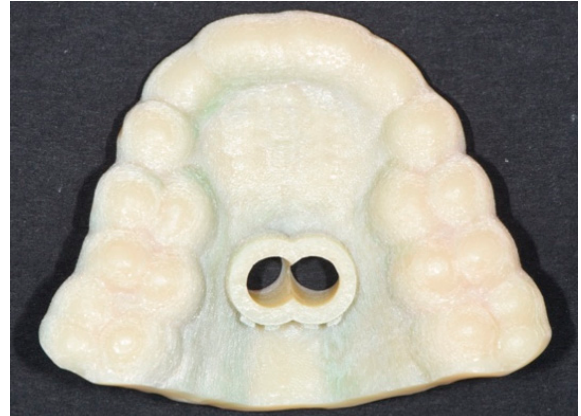
Figure 6. Three dimensional (3D) printed surgical guide for the placement of orthodontic minis-crews.